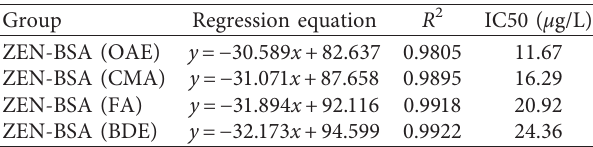
Figure 10: Sensitivity measurement of ZEN pAb to ZEN via icELISA. The values indicate the mean of three independent assays ( n � Table 2: The regression equation, R 2 and IC50 value for ZEN via icELISA.